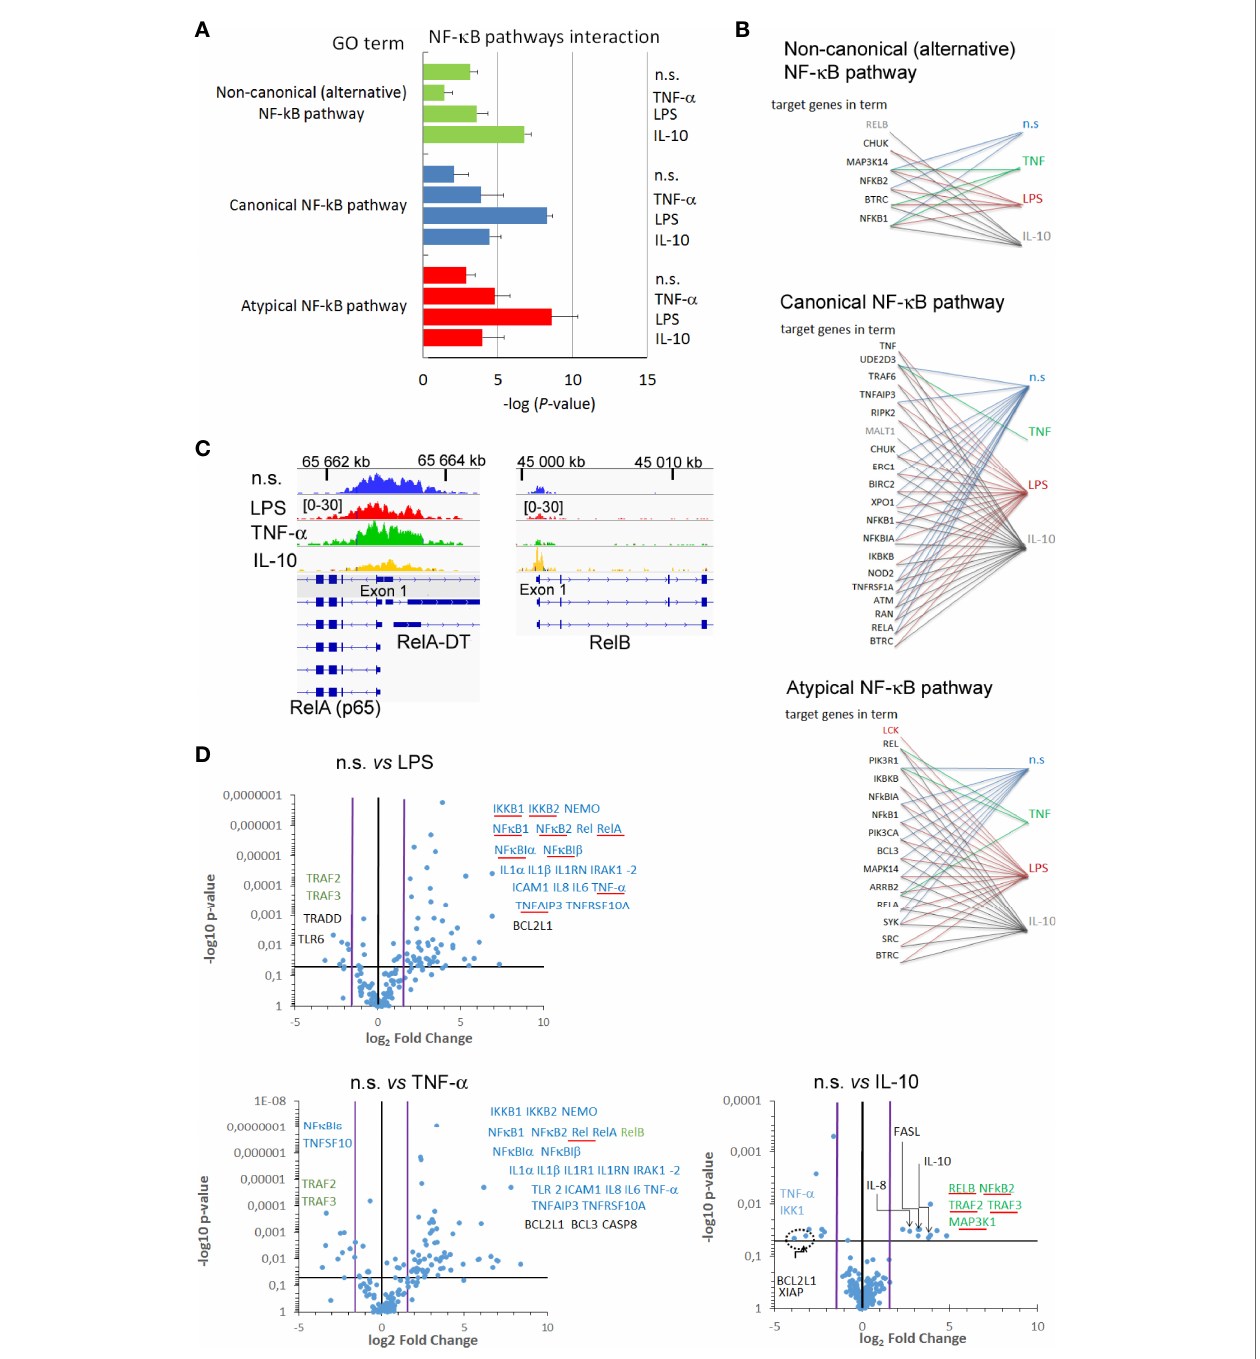
FIGURE 6 | Changes within H3K4me3-marked histone in neutrophils stimulated by IL-10 affected target genes in non-canonical NF- k B pathway. (A) The analyses of GO terms: non-canonical, canonical, and atypical NF- k B pathways. The graph represents mean value ± SD calculated from four independent experiments. (B) The analysis of target genes in the GO terms NF- k B pathway within H3K4me3-marked histone. (C) The exemplary comparison of RelA, RelB, genes among different stimuli. (D) Different target genes proceeding in different stimuli directly re fl ected the pro fi le of mRNA expression of pro- and anti-in fl ammatory factors. Volcano plot demonstrated statistical differences in value vs . relative fold changes to n.s. neutrophils. The blue horizontal line indicates the threshold for the p -value of the t-test ( p <0.05); black vertical line indicates a fold-change in gene expression of 1; pink lines indicate the 3-fold-change in gene expression. Blue arrows indicate mRNA genes associated with canonical NF- k B pathway; green with non-canonical (alternative) and red atypical NF- k B pathway; circle dashed line bordered statistically signi fi cant pro-survival genes. Genes, in which mRNA expression corresponded with H3K4me3 GO analysis, are underlined with a red line; each point represents the mean calculated from four independent experiments; n.s,